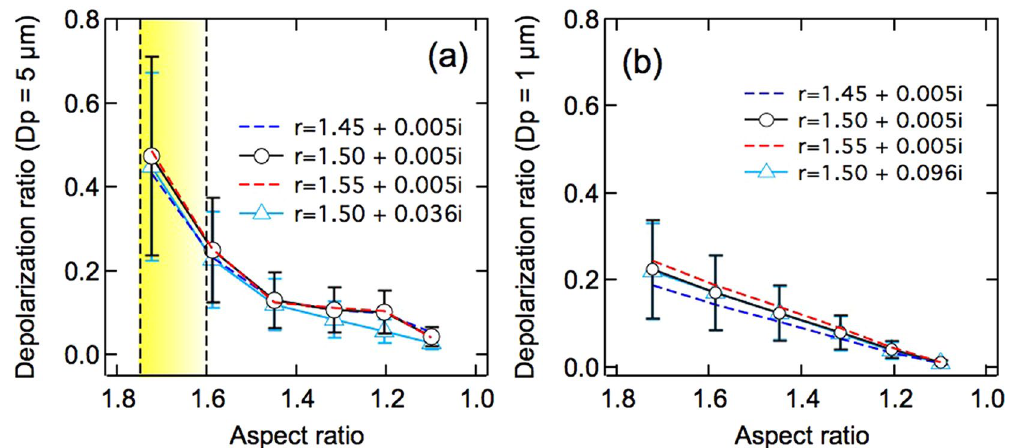
Figure 4. Theoretical simulation of the depolarization ratio of randomly oriented elongated ellipsoid particles as a function of the aspect ratio at Dp = 5 μ m ( a ) and Dp = 1 μ m ( b ) on the basis of the T-matrix